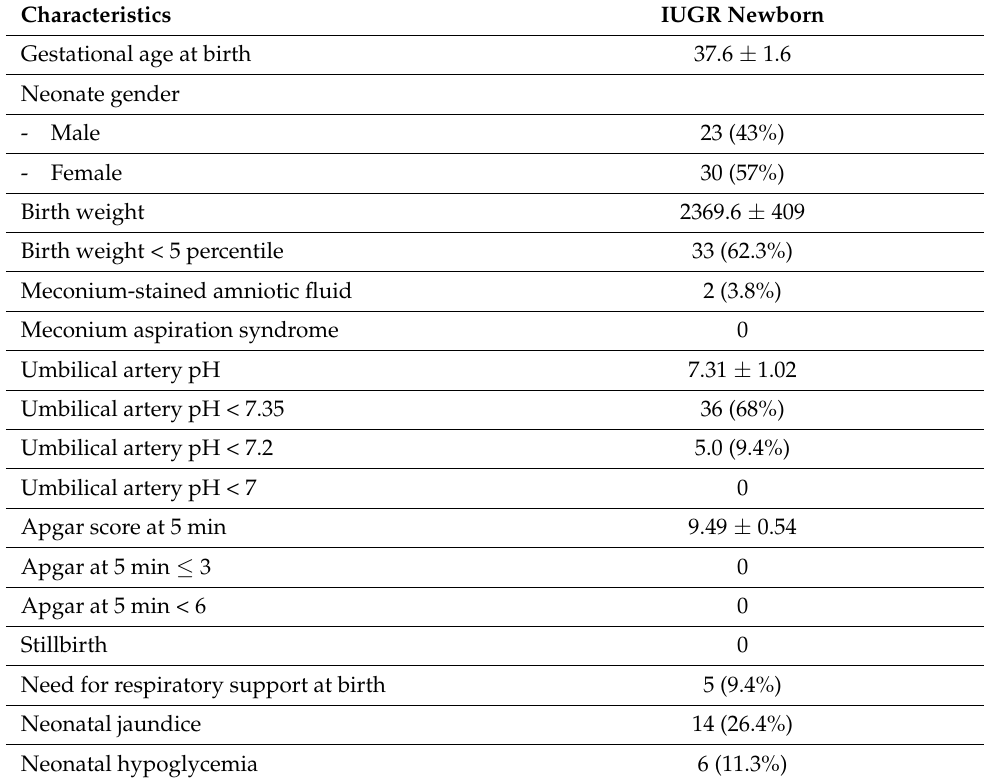
Table 2. Perinatal outcomes of IUGR